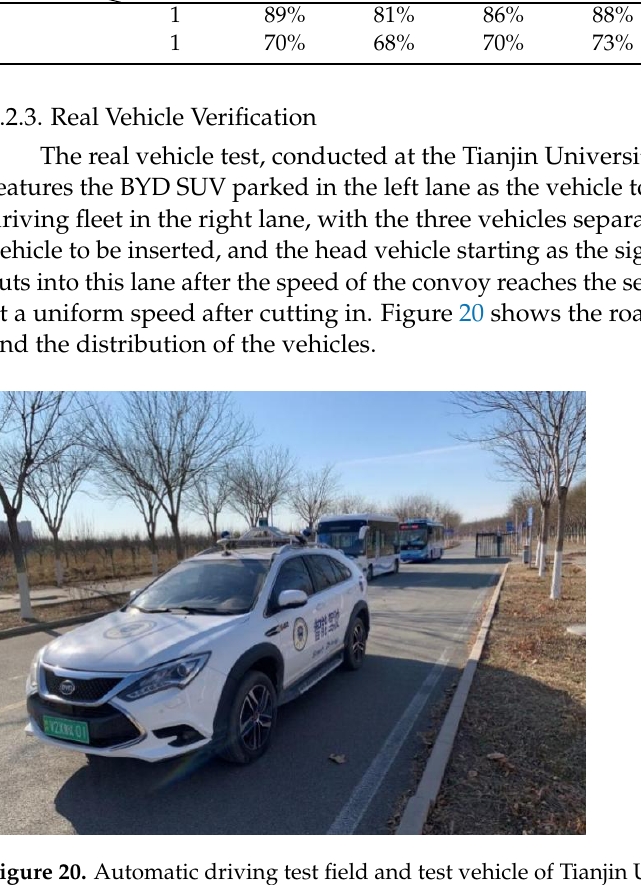
( b ) Figure 21. Speed and relative distance of real vehicle test 1: ( a ) queue vehicle speed without flexible following factor or flexible fading factor; ( b ) queue vehicle transverse – longitudinal trajectory with- out the flexible following factor or flexible decay factor.